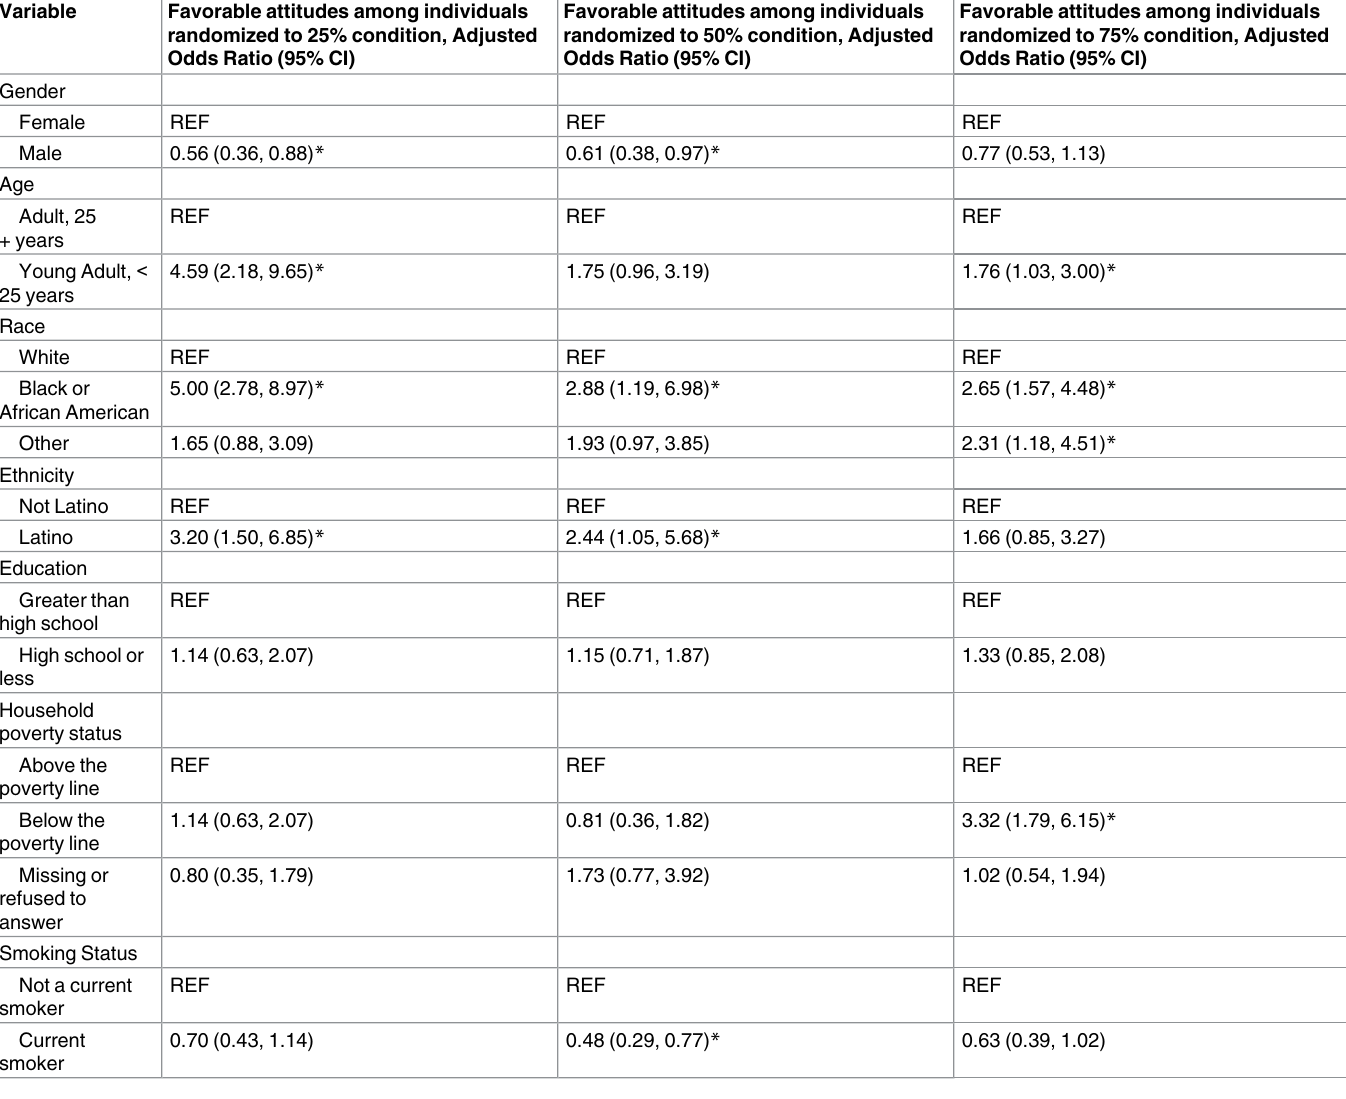
Table 3. Weighted logistic regression results, stratified by experimental